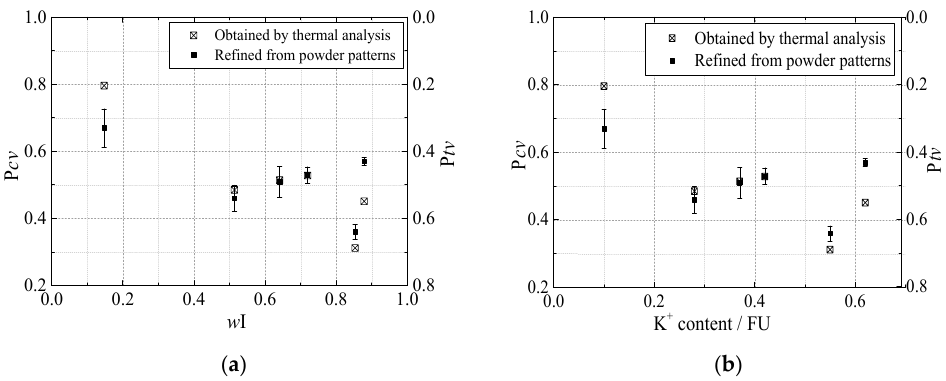
Figure 11. Relationship between the proportion of cv and tv layers and ( a ) the proportion of illitic layers ( w I); ( b ) the potassium content. layers ( w I); ( b ) the potassium